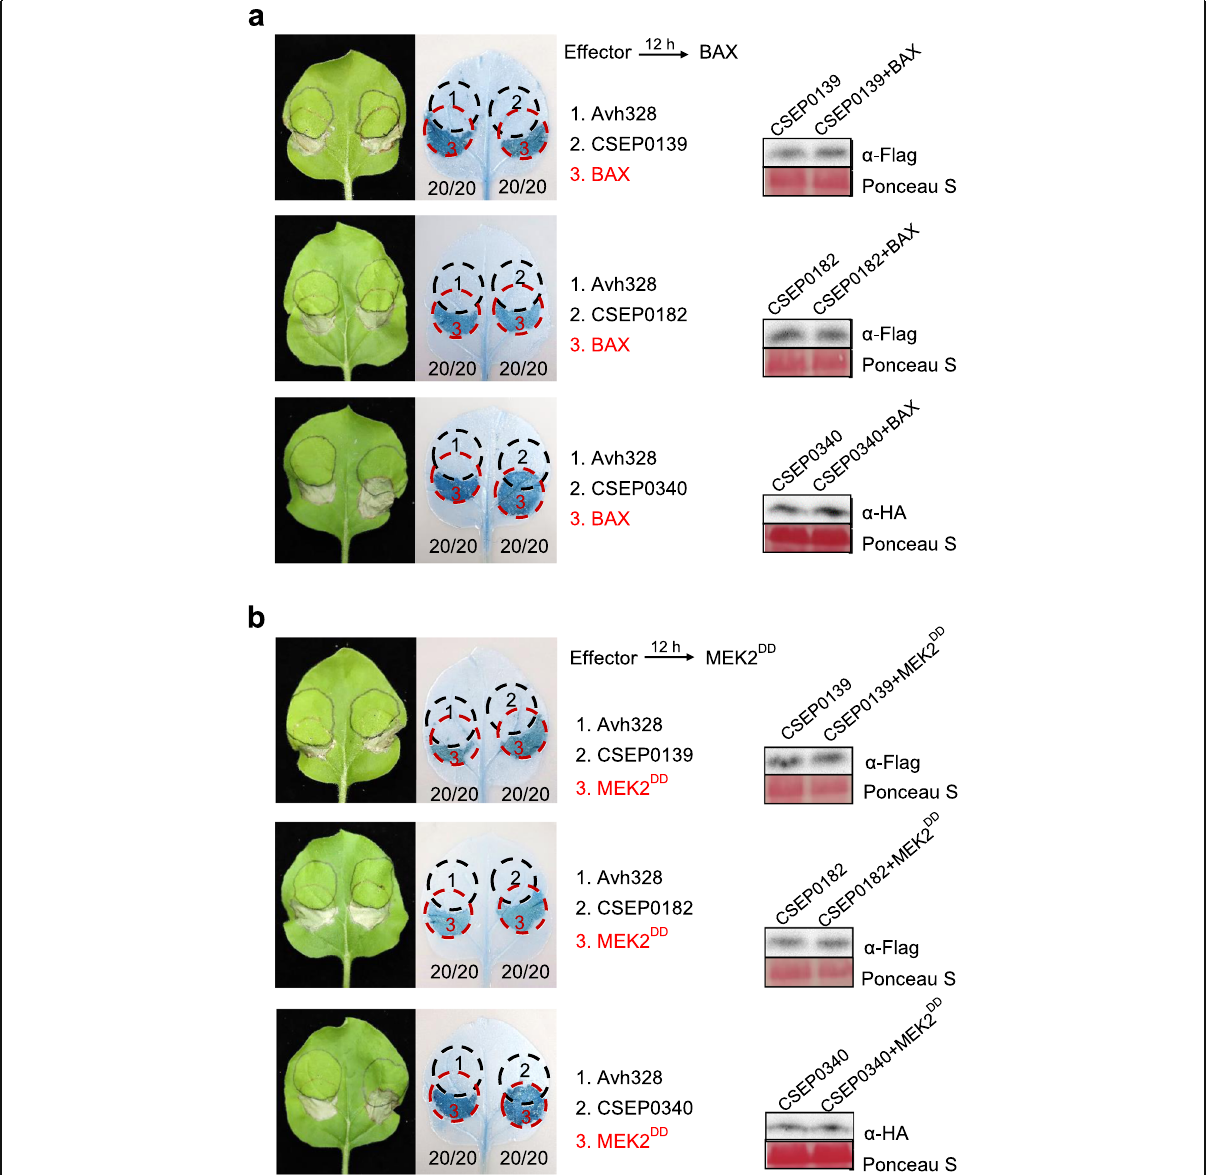
Fig. 2 CSEP0139 and CSEP0182 inhibit BAX- and Nt MEK2 DD -induced cell death in N. benthamiana . a Suppression of BAX-triggered cell death by CSEP0139 and CSEP0182 in N. benthamiana . b Suppression of Nt MEK2 DD -induced cell death by CSEP0139 and CSEP0182 in N. benthamiana . The Oomycete effector Avh328 was used as a positive control, and CSEP0340 as a negative control. Expression of CSEPs, BAX and Nt MEK2 DD was done by agroinfiltration in different but overlapping areas in leaves of N. benthamiana , with 12 h time lapse between the agroinfiltration of the effector and the cell death inducer. Cell death was visualized by trypan blue staining, and photographs were taken at 5 days after infiltration. Protein accumulation of CSEP fusions were detected at 2 days after infiltration by Western